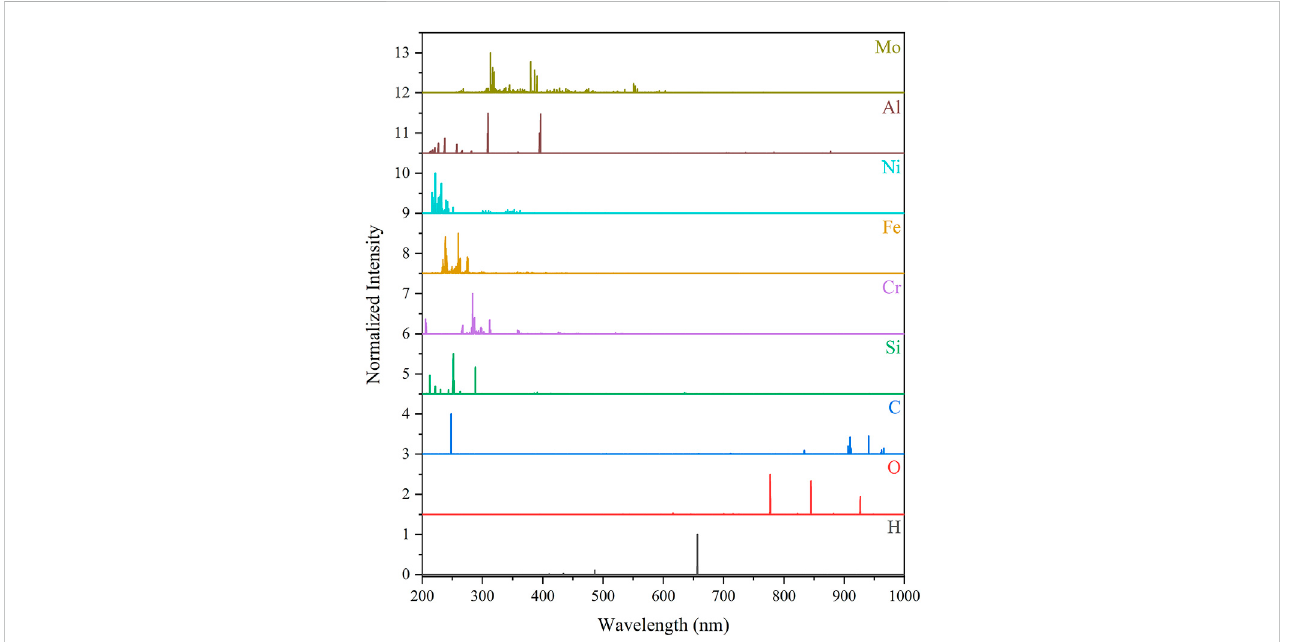
FIGURE 6 Selected corrosion species ’ LIBS emission pro fi les compared at a plasma temperature of 1 eV and electron number of 10 17 cm − 3 . The spectral intensities have been normalized (0 – 1) to their maximum intensity for comparison